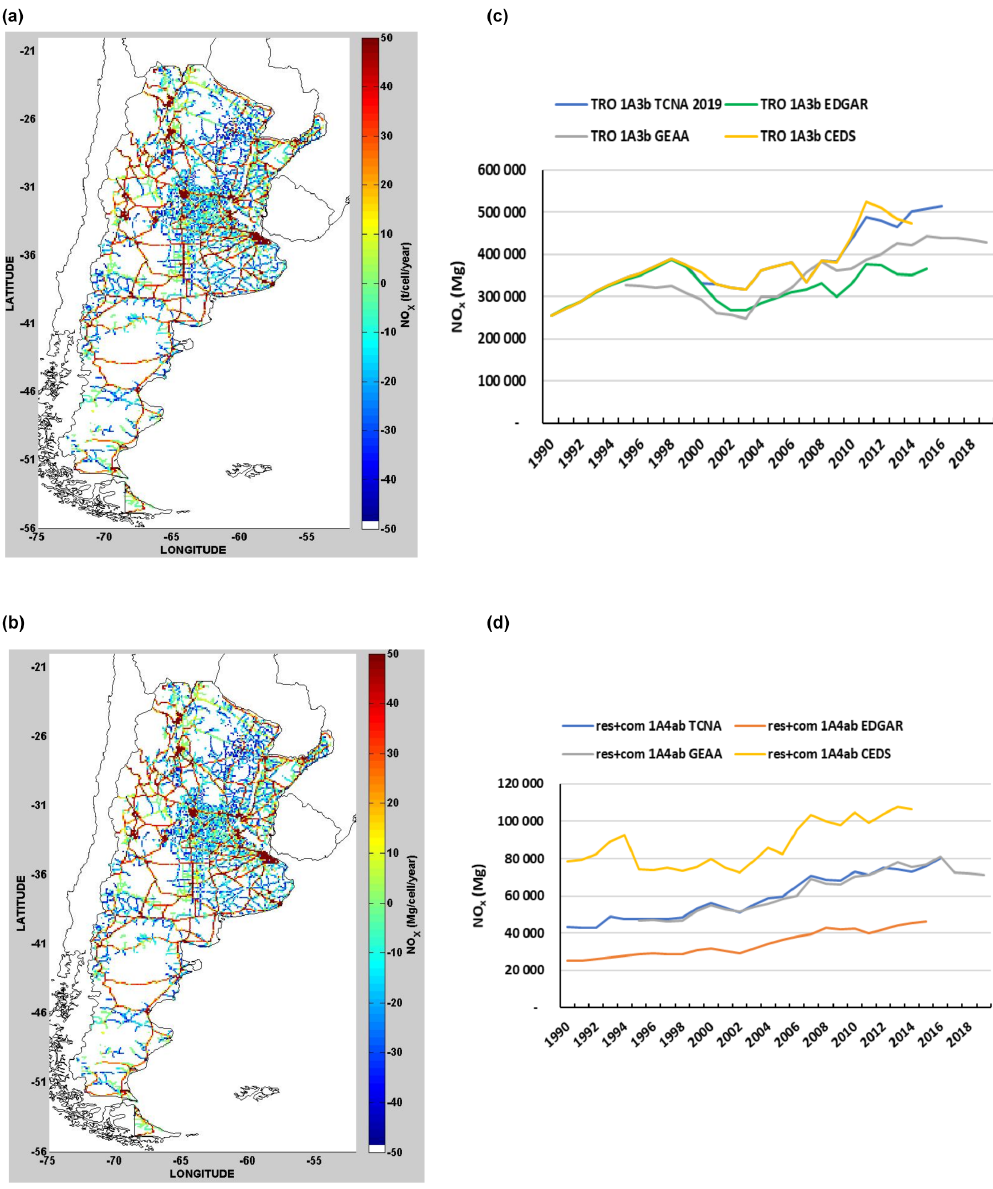
Figure 9. GEAA and EDGAR annual NO x emissions from the road transport sector: (a) differences (GEAA-EDGAR; in Mgyr − 1 per cell) and (c) annual series. GEAA and EDGAR annual NO x emissions from residential and commercial activities: (b) differences (Mgyr − 1 per cell) and (d) annual series. Maps are represented at 0 . 1 × 0 . 1 resolution for 2015. CEDS (light blue) and TCNA (green) profiles are also included for